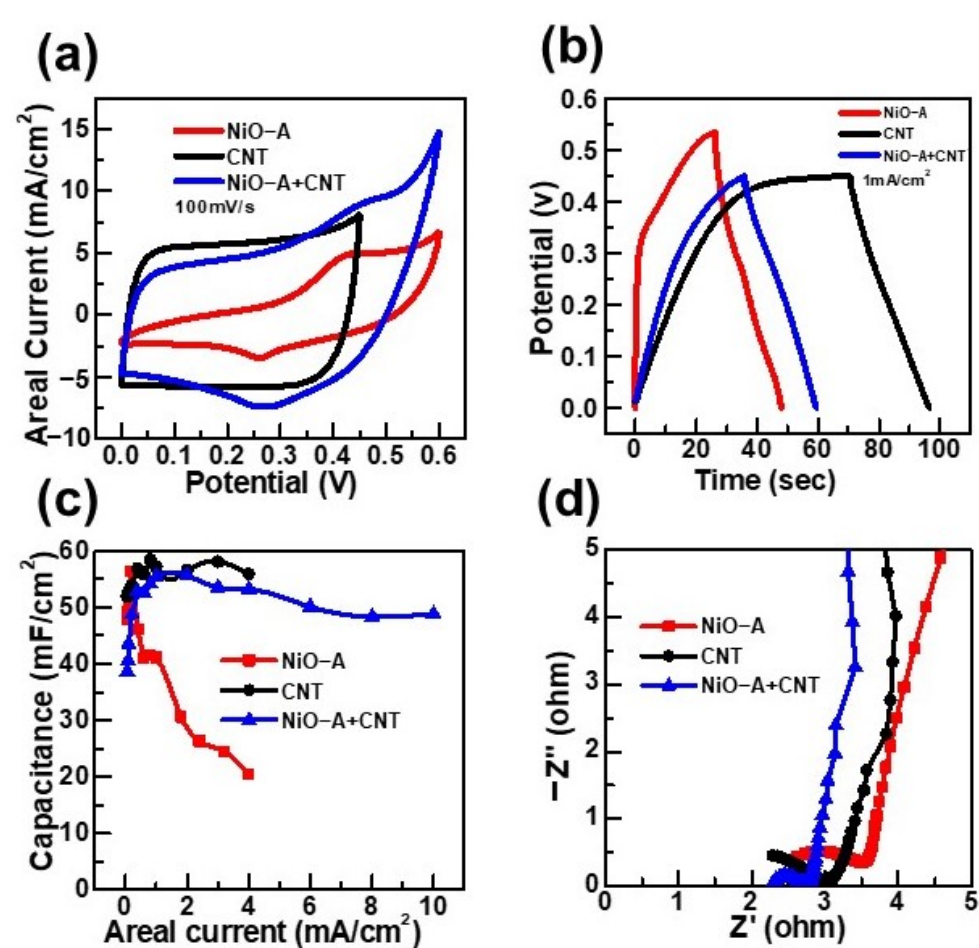
Figure 5. Comparisons of electrochemical storage performance of NiO-A, CNT, and NiO-A+CNT half-cells: ( a ) CV curves; ( b ) CD curves; ( c ) Areal capacitance functions; ( d ) Nyquist plot of EIS.